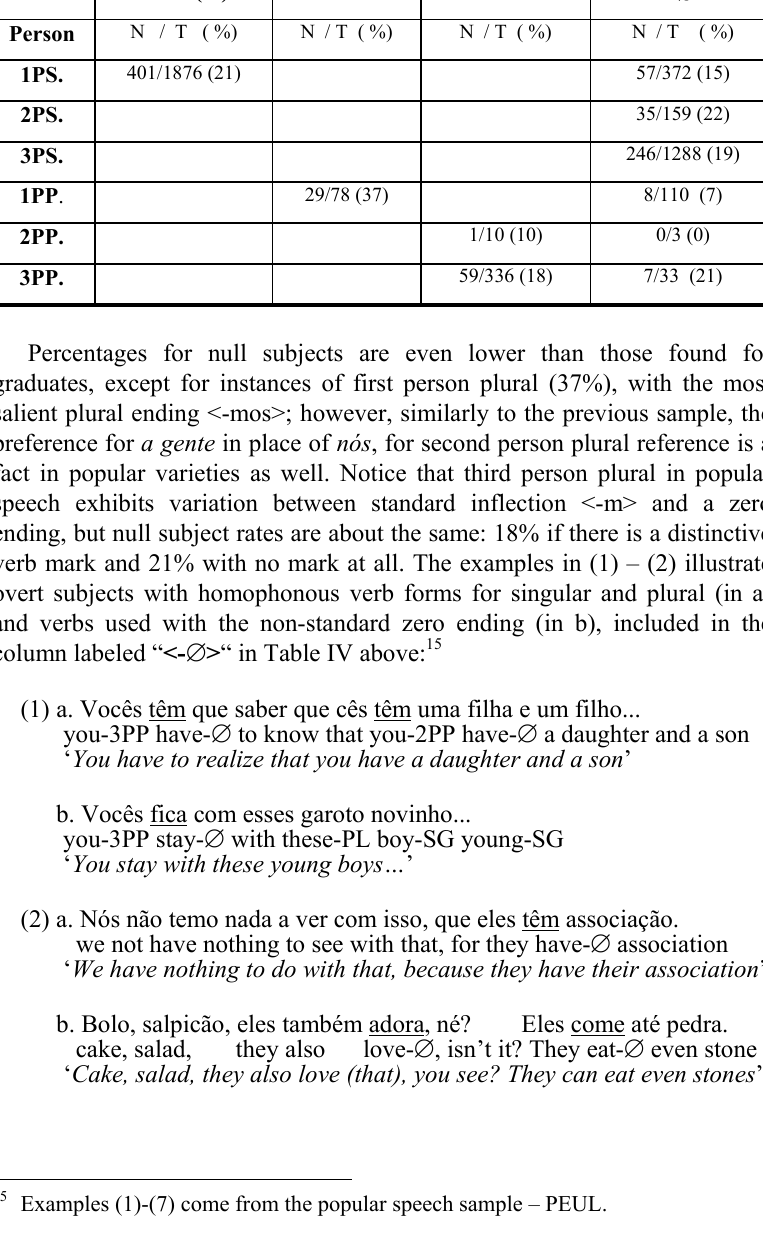
(Duarte, 2007b: 270)